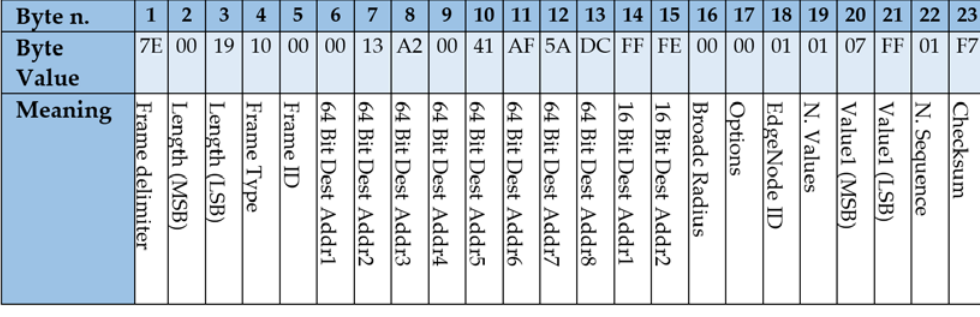
Figure 5. Measurement frame used by the microcontroller at the Edge Nodes with the process values for a SISO control system.